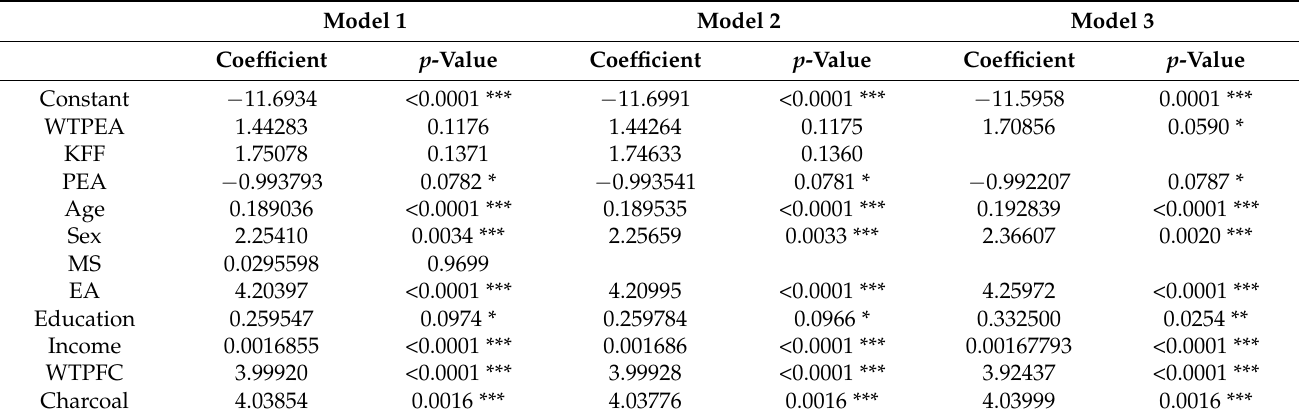
Table 5. Determinants of the willingness to pay amount